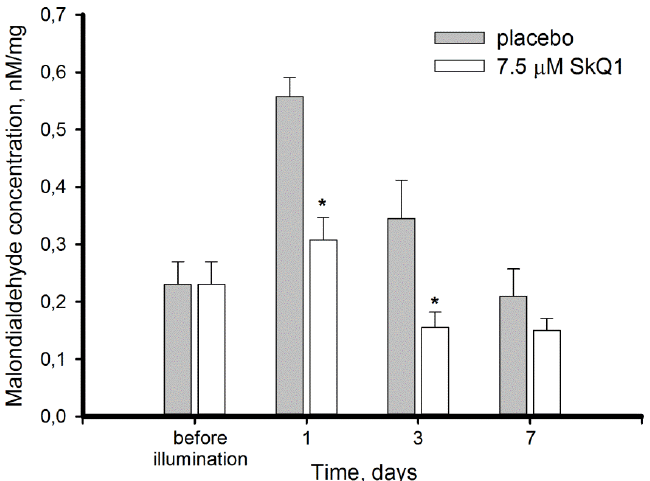
Figure 2. Malondialdehyde (MDA) concentration in homogenates of intact and illuminated rabbit retinas with or without premedication with 7.5 μM SkQ1. MDA concentration was determined by thiobarbituric acid assay. Each bar represents the data obtained from six animals (12 eyes). * p ≤ 0.05 compared with the values measured in the control animals.